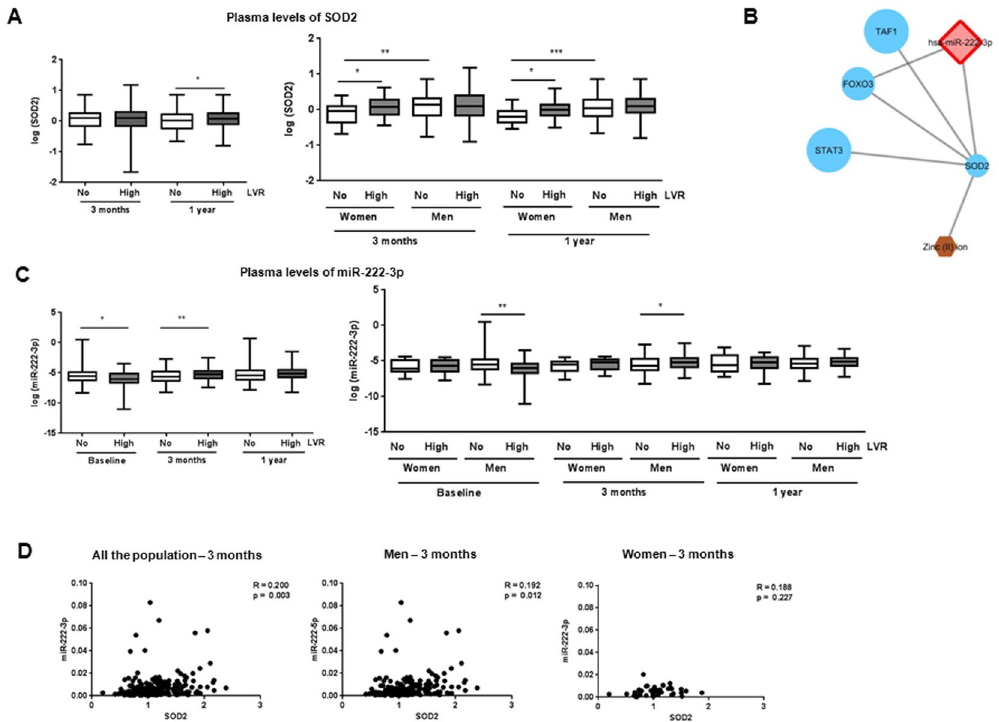
Figure 3. Circulating SOD2 and miRNAs plasma levels of REVE-2 patients. REVE-2 was a multicenter study that enrolled 246 patients with anterior wall Q-wave MI followed for one year with serial echographic studies at hospital discharge (day 3 to day 7) then 3 months and 1 year after MI and serial blood sampling at hospital discharge then 1 month, 3 months, and 1 year after MI. REVE-2 patients (n = 224) were divided as no remodelers (LVR < 20%, n = 138)) (white) and high remodelers (LVR > 20%, n = 86) (grey), according to the LV remodeling determined as ((EDV1year − EDVbaseline)/EDVbaseline). ( A ) Quantification by ELISA of SOD2 in plasma from no LV remodeling (white, n = 138) and high LV remodeling (grey, n = 86) patients after 3 months and 1 year post-MI for all the population (left panel). Analysis were also performed by separating women (n = 46, 24 no LVR and 20 high LVR) and men (n = 200, 114 with no LVR and 66 with LVR) (right panel). Data are expressed as log (SOD2) and are represented in box plot with the central rectangle for the interquartile range, the segment inside the rectangle for the median and the segment outside for the minimum and maximum. ( B ) Visualization of the REVE-2 molecular network model 17 at baseline centralized on direct miR-222-3p interaction. Detailed information are provided as Fig. 2 and Supplementary Table 3. ( C ) Quantification by RT-qPCR of miR-222-3p in plasma extracted from REVE-2 patients at baseline and after 3 months and 1 year post-MI for all the population (left panel). Analysis were also performed by separating women (n = 46, 24 no LVR and 20 high LVR) and men (n = 200, 114 with no LVR and 66 with LVR) (right panel). Data are expressed as log (miR/cel39) and are represented in box plot with the central rectangle for the interquartile range, the segment inside the rectangle for the median and the segment outside for the minimum and maximum. * p < 0.05; ** p < 0.01 compared to no LV remodeling patients. ( D ) Pearson correlations between SOD2 and miR-222-3p in REVE-2 patients. The scatter plots show the correlation between SOD2 and miR-222-3p plasma levels at 3 month post-MI for all REVE-2 population (n = 246) (left panel), for men (n = 200) (middle panel) and women (n = 46)(right